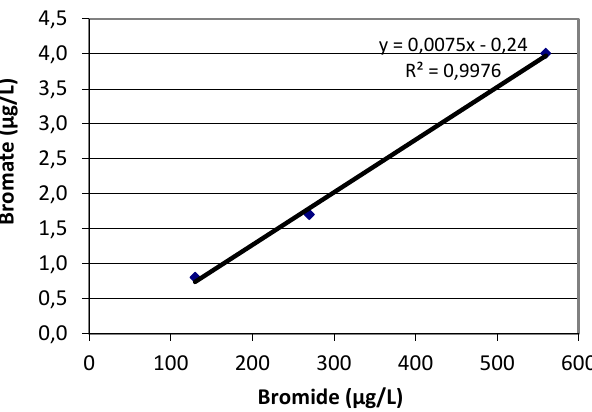
Figure 7. Correlation between water temperature, DOC and bicar- bonate concentration.